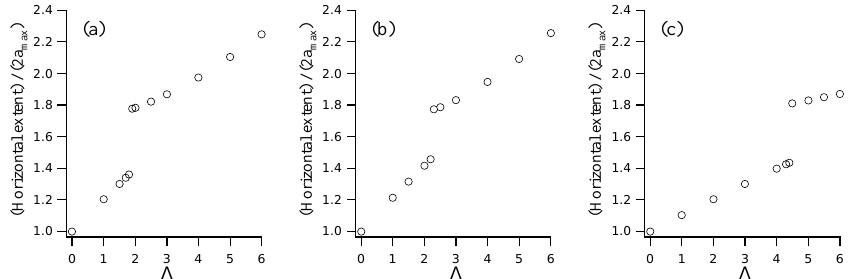
FIG. 5. The horizontal extent of the particle initially located at the inner edge of the core in the cases with h x (cid:1) 0.9 . Three different combinations of M and j are considered, i.e., (a) M (cid:1) 0.13 and j (cid:1) 0.15 , (b) M (cid:1) 0.066 and j (cid:1) 0.15 , and (c) M (cid:1) 0.13 and j (cid:1) 0.075